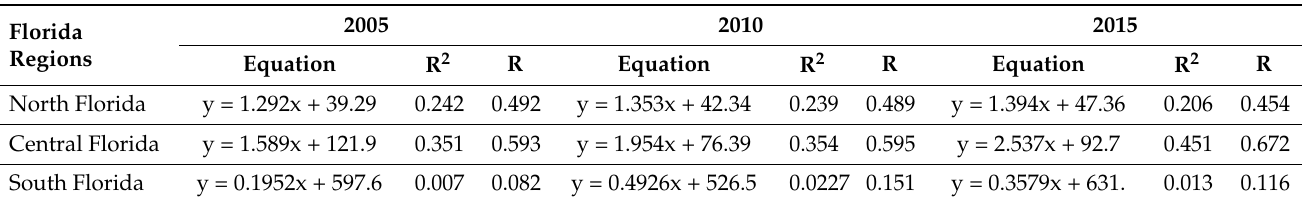
Table 2. Results of linear regression for correlation assessment of public supply and population in